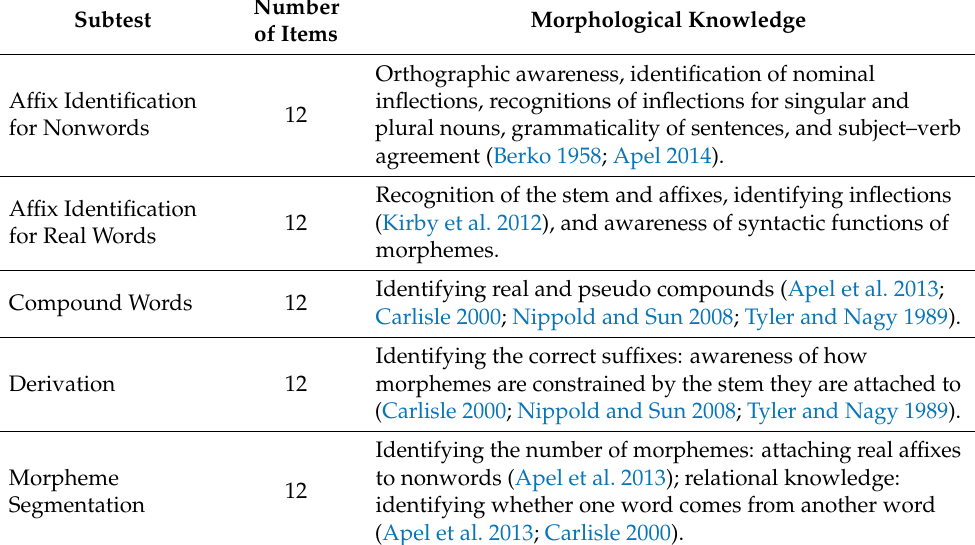
Table 2. Subtests of the morphological awareness